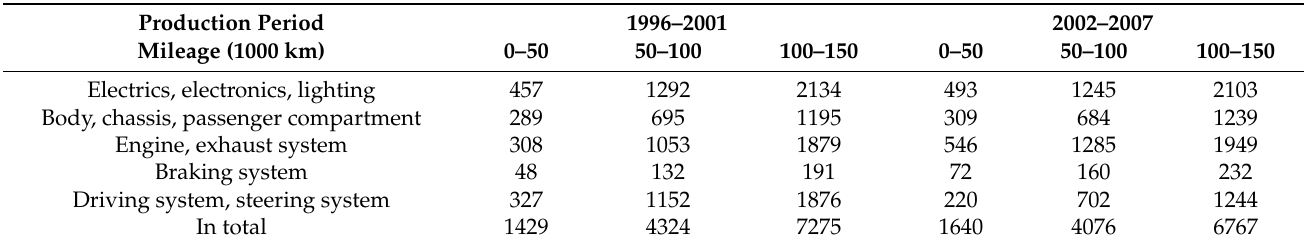
Table 9. Energy input in MJ related to the failure rate of units for new parts in a passenger car depending on its mileage and production period.